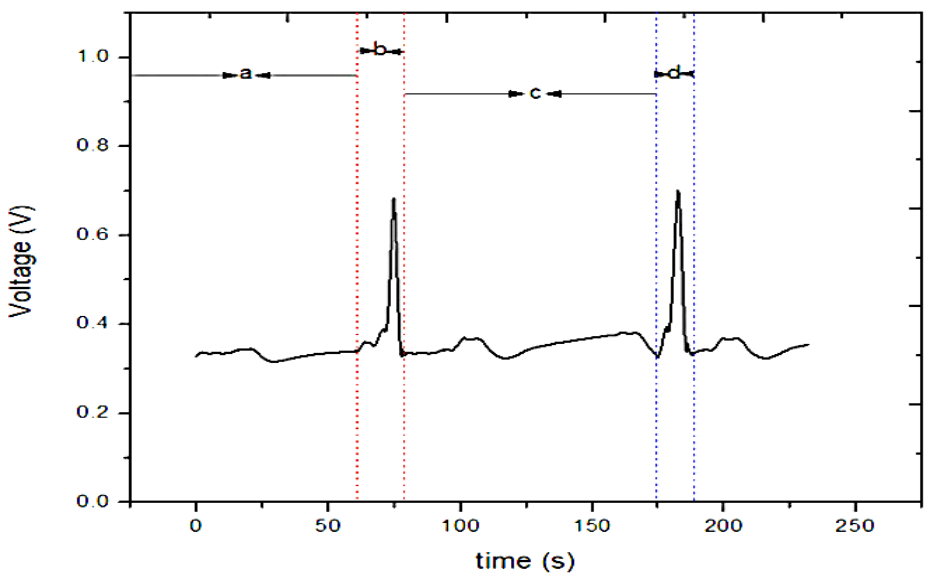
Figure 11. Temporal trend of the galvanic skin response: ( a ) Initial condition; ( b ) first bump; ( c ) recovery state before the second blow; ( d ) second bump [45] (Reprinted with permission from ref. [45]. Copyright 2021 IEEE).